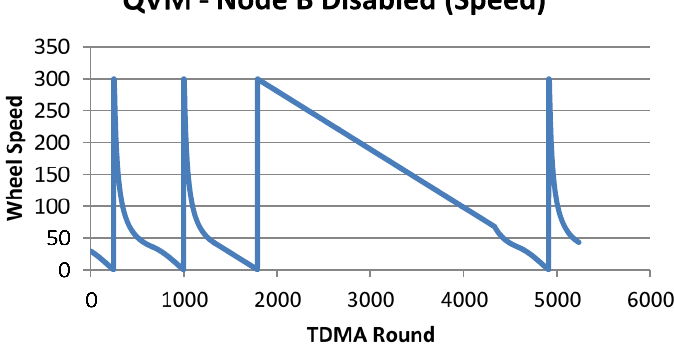
Figure 14. Results of disabling Node B of QVM. TDMA stands for Time Division Multiple Access method of multiple nodes to the bus, while TDMA Round is a duration of a single experiment.